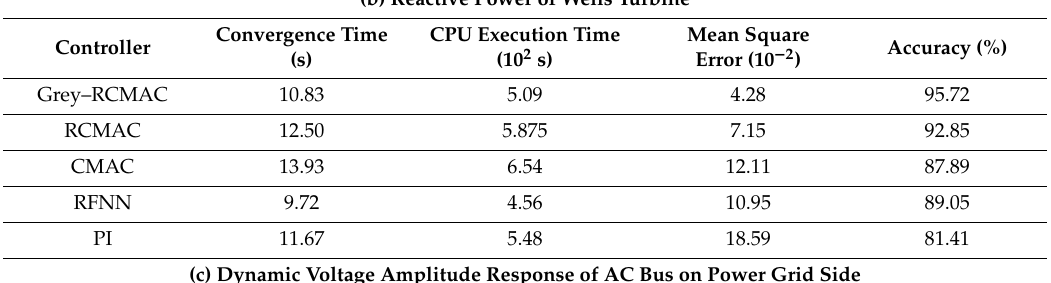
(b) Reactive Power of Wells